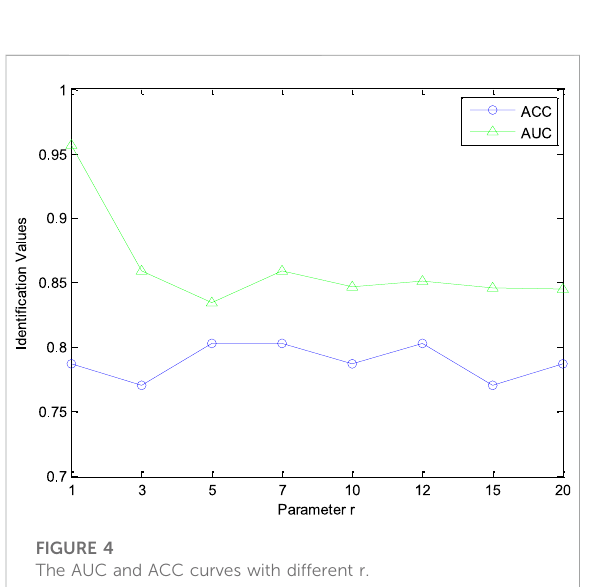
FIGURE 4 The AUC and ACC curves with different r.